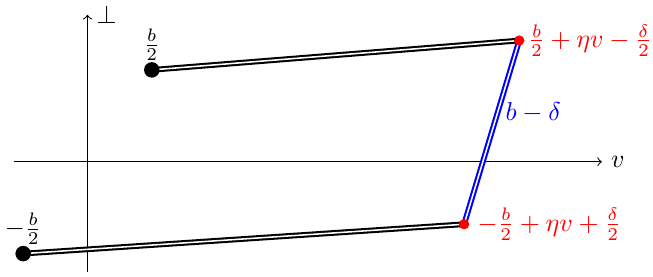
Figure 2 . Generic staple-shaped Wilson line defined in eq. (2.4). Black double-lines extend along ηv , and the blue segment along b − δ closes the staple. For certain choices of δ , red points can be cusps. Edges may extend along the conjugate direction P , which is not